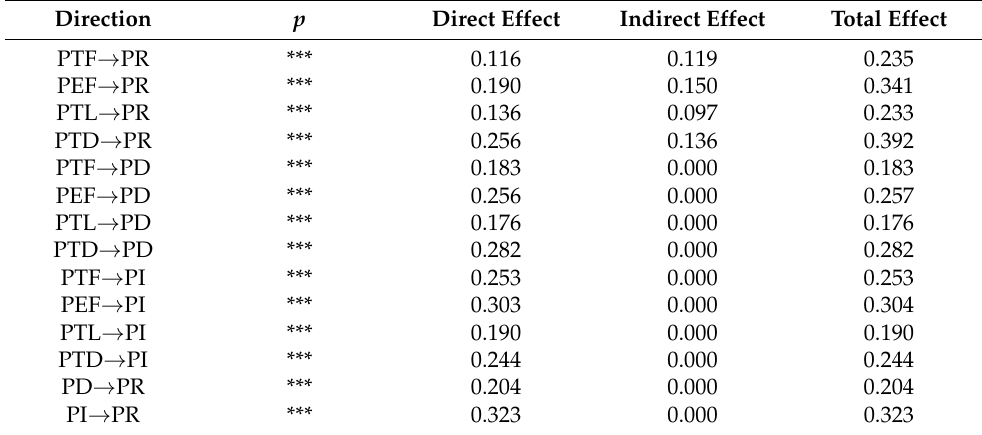
Table 5. Tests for mediation effects